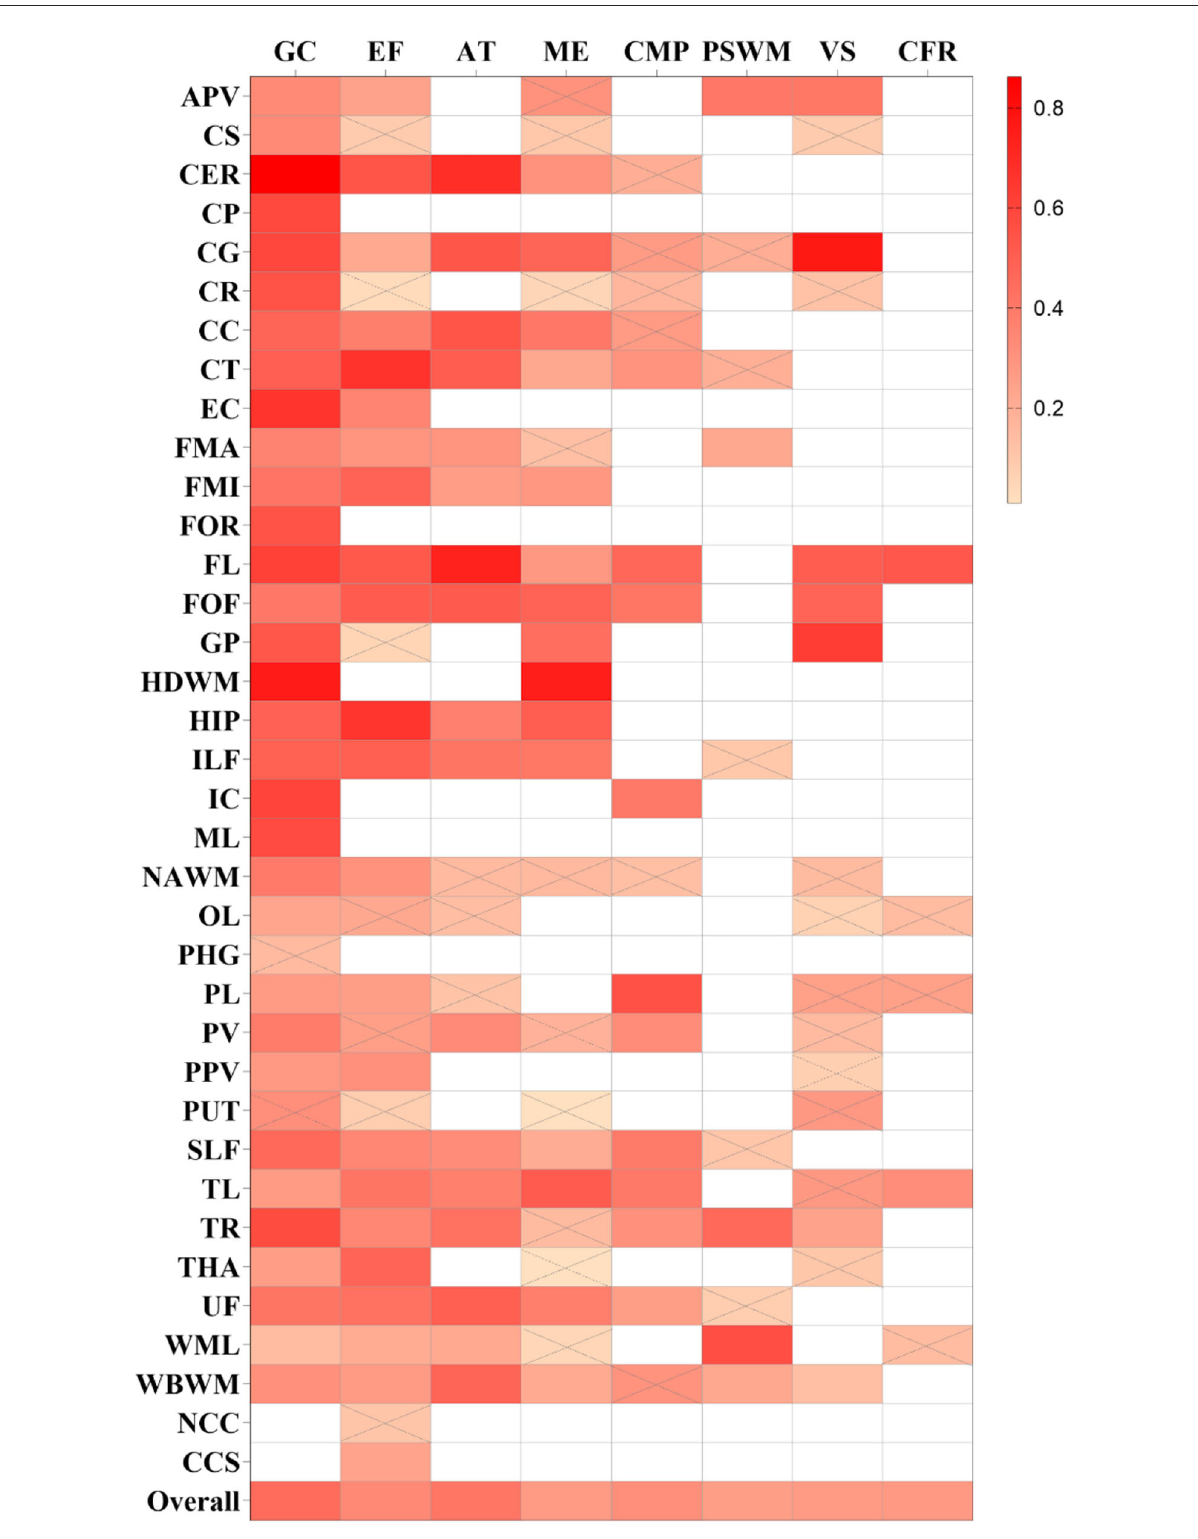
FIGURE3 Summary correlation coefficients between different cognitive domains and fractional anisotropy (FA) in varying regions with color scales. Correlation matrix for the r -value of meta-analytic tests, the larger r -values of squares are with a brighter color. Squares with a white color represent no studies that report the relationship. Squares with gray slashes denote insignificant correlation ( p >